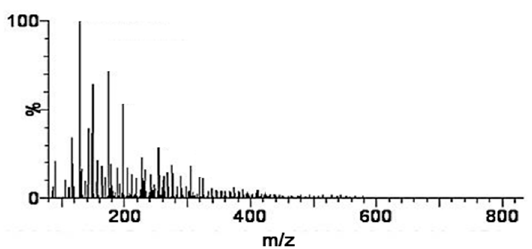
Figure 2. Mass spectrometric analysis of the silk peptide. Typical chromatogram of SP obtained by using high resolution TOF MS ES+ system.